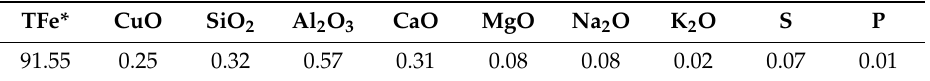
Figure 10. The micrography of the direct reduction of iron (DRI) product ( a , b ); the EDS result of point A ( c ); the EDS result of point B ( d ).